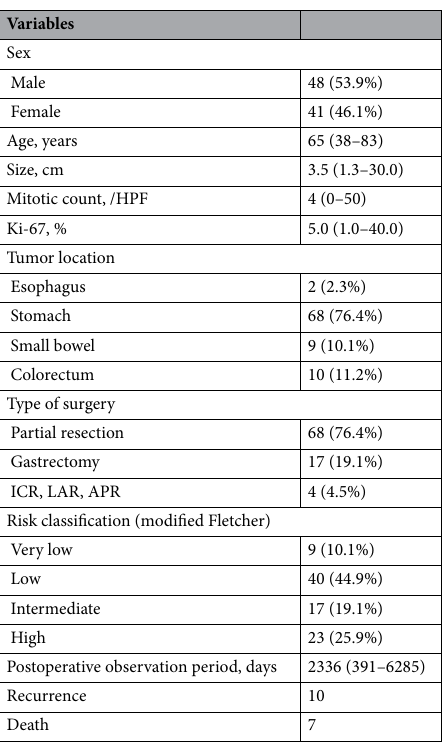
Table 1. Patient characteristics. HPF, high power field; ICR, ileocecal resection; LAR, low anterior resection; APR, abdominoperineal